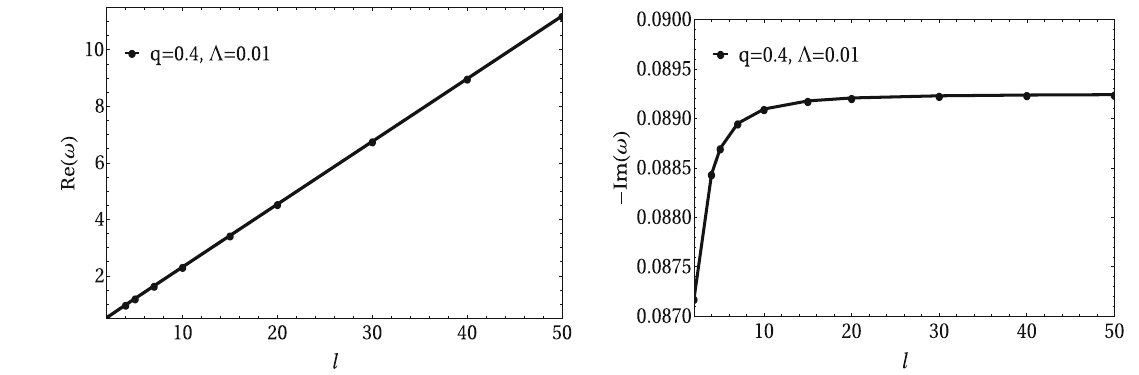
Fig. 2 Variation of Re ω and -Im ω with multipole number (cid:12) for (cid:2) = 0 .